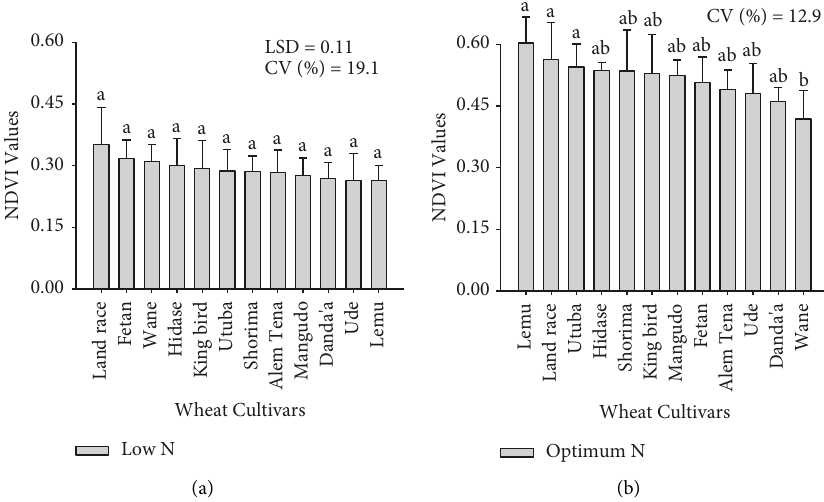
Figure 2: NDVI values of wheat cultivars under low and optimum N supply. Bars followed by similar letters under similar N level are not significantly different from each other at 5% probability